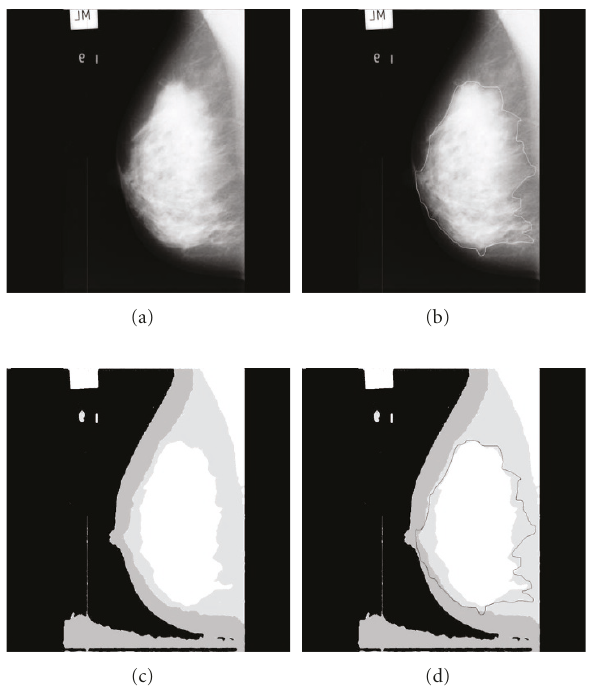
Figure 6: Segmentation results: (a) original mammogram mdb003; (b) radiologist’s manual segmentation; (c) obtained segmentation with initialization INIT A and SA algorithm (80 iterations); (d) ob- tained segmentation compared to radiologist’s manual segmenta- tion ( ρ = 0 . 58).